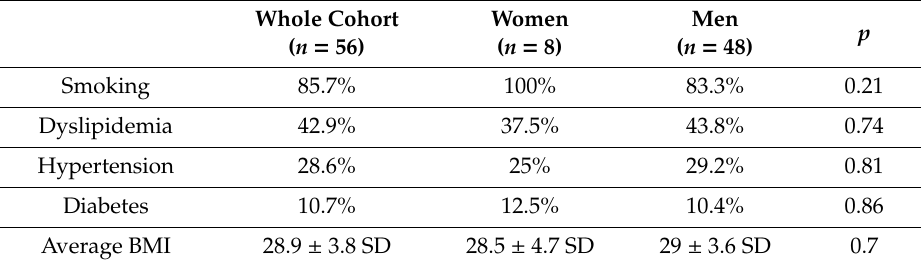
Table 1. Known cardiovascular risk factors of the cohort after